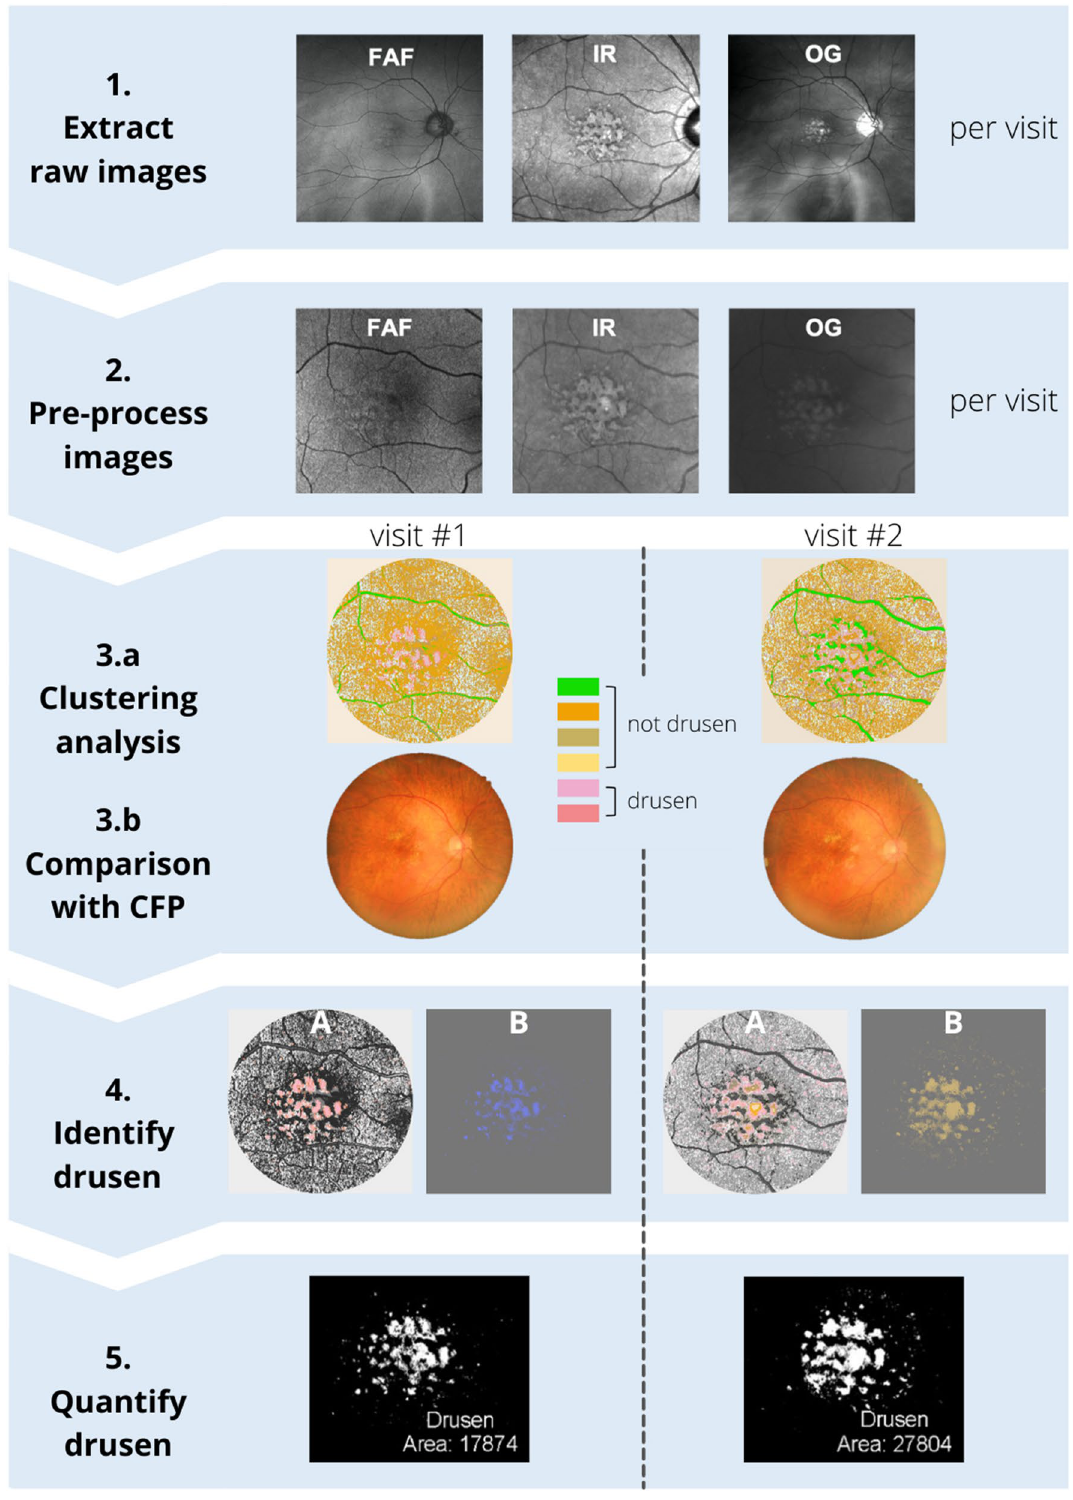
Figure 1. Summary of the methodology. Step 1: Extraction of raw images from each imaging modality at each visit. Note that images vary in field of view due to use of different imaging modalities. Step 2: Pre-processing of images as described in Ly et al. 33 Images are registered, background corrected, and contrast enhanced. Step 3.a: Clustering analysis using pattern recognition is performed across the three images yielding a single multispectral image where each color represents a distinct spectral theme class. Step 3.b Spectral theme classes assigned as drusen/not drusen using reference color fundus photograph annotated for drusen by clinical experts. Step 4: Identification of spectral theme classes attributed to drusen from the pseudocolored image. (A): Spectral theme classes identified as drusen were thresholded from all other theme classes in the pseudocolored image and (B) Drusen spectral theme classes were merged to create a duochrome image. Step 5: Quantification of drusen. Total number of pixels attributed to drusen were quantified from duochrome images at each visit and drusen change calculated as a percentage difference between the two visits. CFP: Color fund photograph, FAF: fundus autofluorescence, IR: infrared, OG: green scanning laser ophthalmoscopy